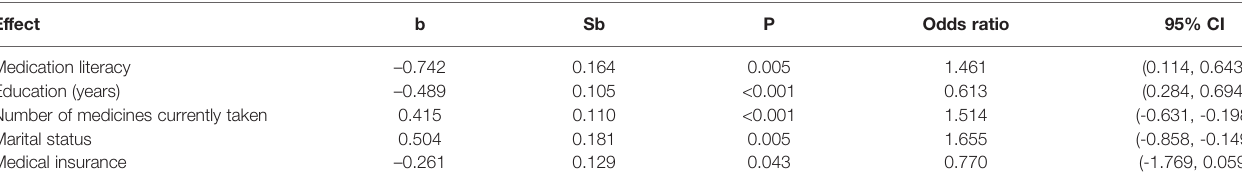
TABLE 5 | Results of binary logistic regression analysis of determinants of medication adherence for inpatients with coronary heart disease Changsha, Hunan, China (N = 470). Effect